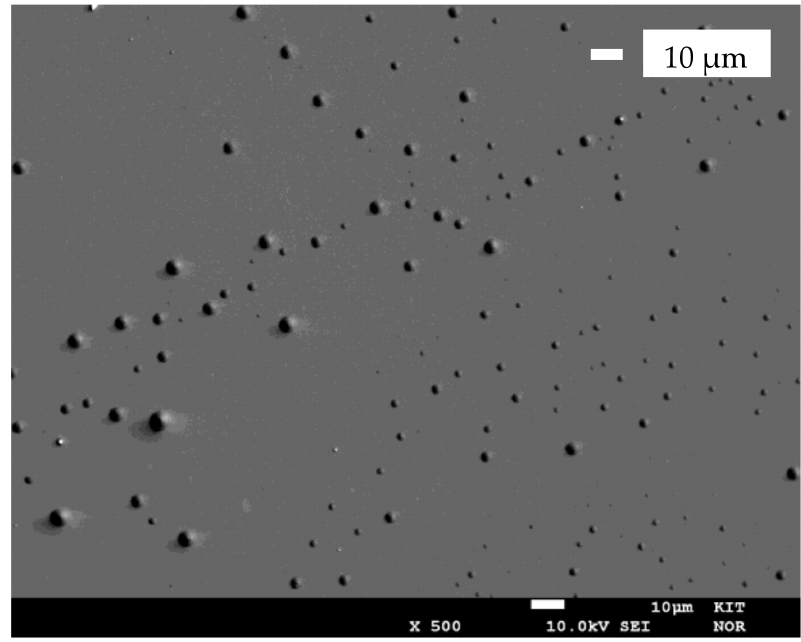
Figure 7. SEM Image of the top view of the FAS coating on a silicon substrate.